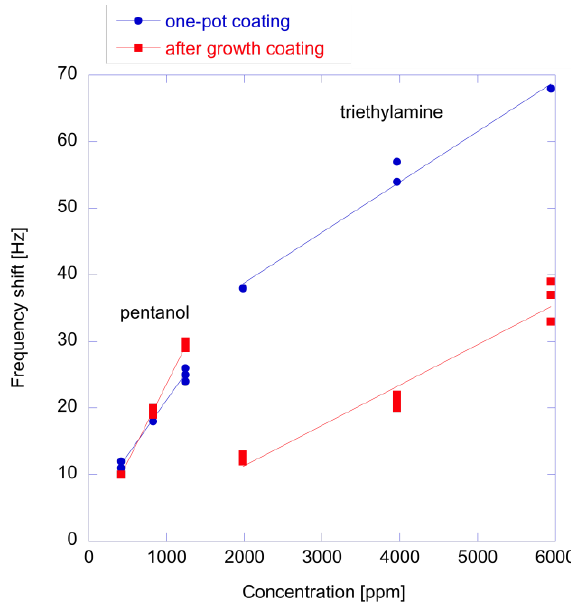
Figure 7. Response of QMB sensors coated with one-pot and after-growth prepared ZnTPPCOOH-functionalized ZnO nanoparticles exposed to different growing concentrations of pentanol and triethylamine. Data from reference [24].